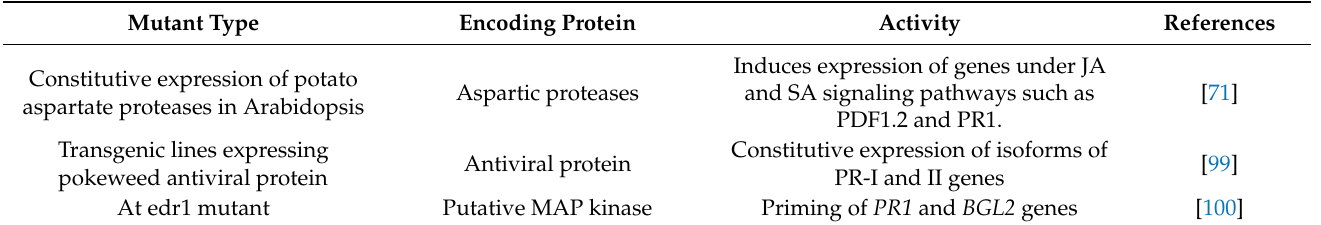
Table 1. List of mutants developed, which induce constitutive expression of defense-related genes. Mutant Type Encoding Protein Activity Induces expression of genes under JA Constitutive expression of potato Aspartic proteases and SA signaling pathways such as aspartate proteases in Arabidopsis PDF1.2 and PR1. Transgenic lines expressing Constitutive expression of isoforms of Antiviral protein pokeweed antiviral protein PR-I and II genes At edr1 mutant Putative MAP kinase Priming of PR1 and BGL2